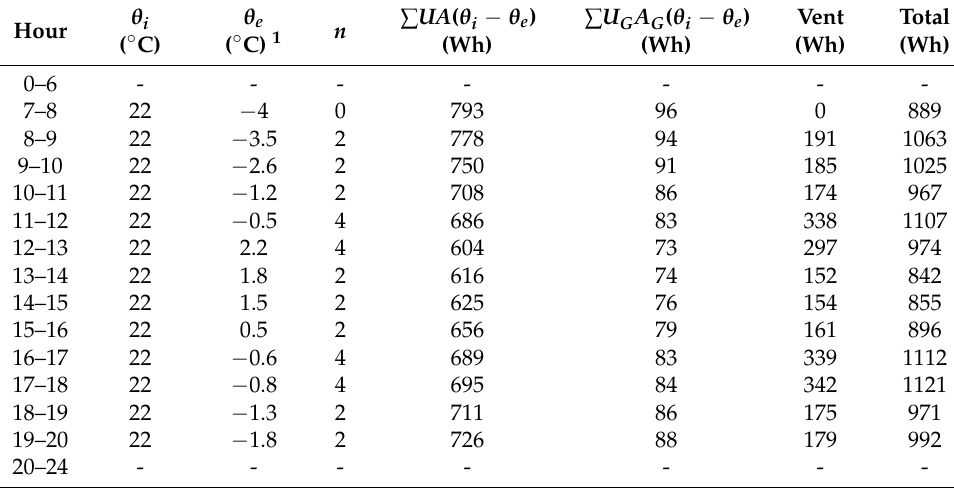
Table 2. Winter heating loads on 5 January